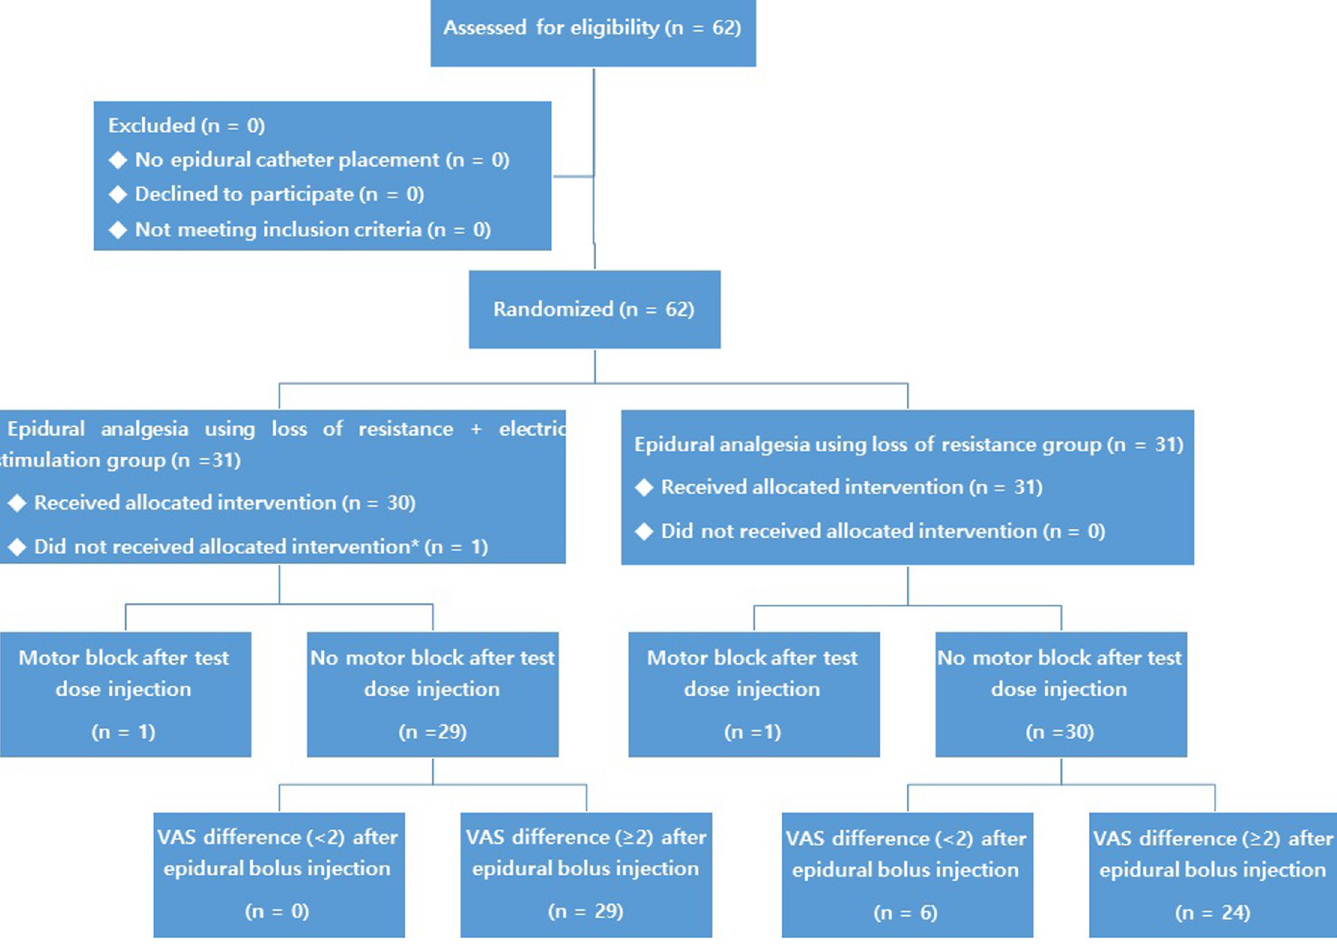
PLOS ONE | https://doi.org/10.1371/journal.pone.0209967 January 11,